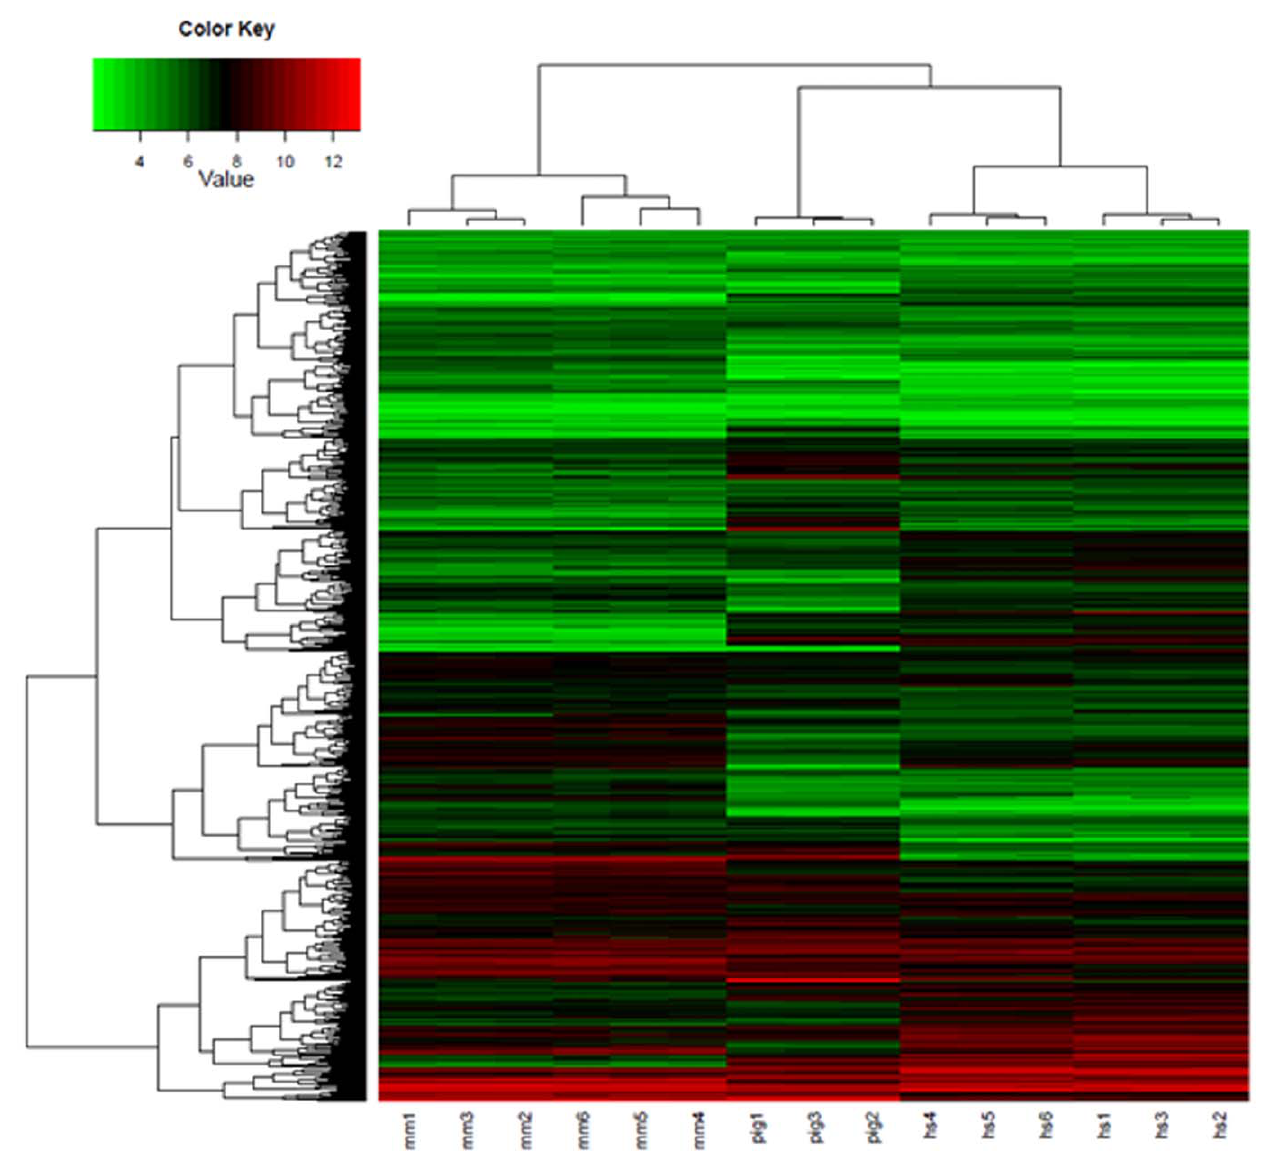
Figure 4. Global gene expression profile of EpiSC-like pESCs. Each row represents the expression of a single gene and columns indicate samples; mESCs, pESCs and hESCs. The 3 large groups in the heatmap were identified. Hierarchical clustering result showed the global gene expression pattern of pESCs is similar to hESCs. mm 1, 2 and 3; cell line R1, mm 4, 5 and 6; J1, pig 1, 2 and 3; cell line PES5, hs 1, 2 and 3 : cell line HUES6, hs 4, 5 and 6 : cell line